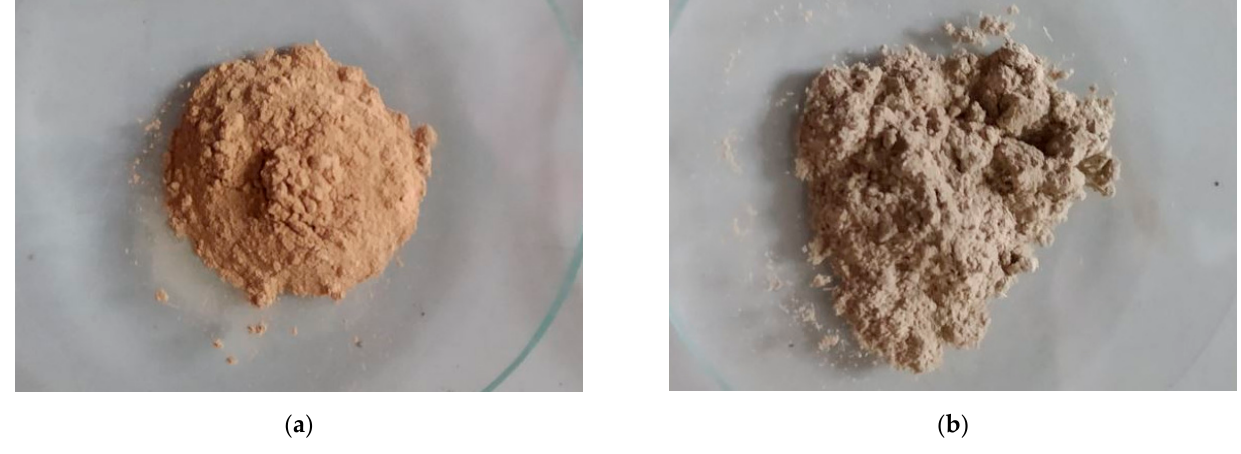
Figure 2. Milled straw dust of: ( a ) Type-1 straw; ( b ) Type-2 straw.